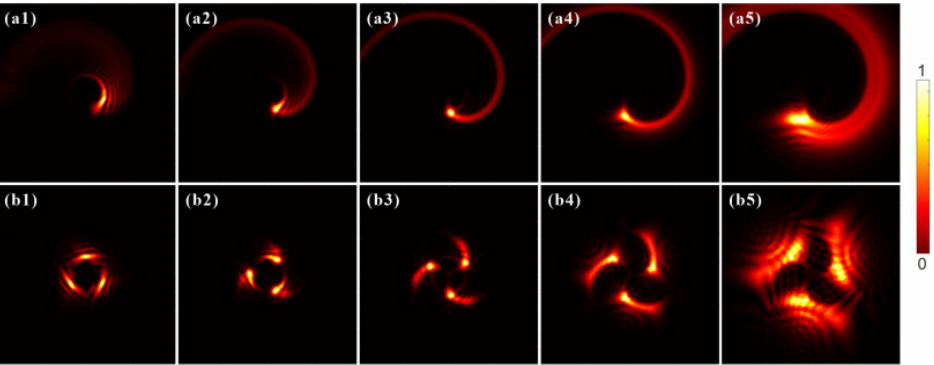
Figure 3. The focusing was carried out with a high-NA oil-immersion objective lens and the refractive index of the oil was n = 1.518. As the beam propagates in such a high-NA system, its intensity profile changes with respect to the propagation distance rapidly. It is observed in Figure 4a1 that, when MHCB with parameter K = 0, m = 3, α = 6 is at a distance of z = − 2 λ away from the focal plane, there exists a curved moon-shaped main lobe of light intensity rotating along the center of the optical axis, and some weaker side lobe light intensity distribution is in the periphery. As the beam approaches the focal plane—see Figure 4a1,a2—the strongest light intensity in the main lobe of light intensity rotates around the optical axis. At the same time, the peripheral side lobes contract together. The intensity distribution at the focal plane is very clearly observed as a spiral shape as shown in Figure 4a3. As the light passes through the focal plane, the spiral light intensity gradually spreads out to form a wider band-like light intensity distribution, and, at the same time, the center of the strongest light intensity rotates around the optical axis in Figure 4a4,a5. For the MHCB with m = 3, α = 6, three main lobes with some side lobes can be observed in the intensity profile in Figure 4b1,b2 when z = − 2 λ . As it approaches the focal plane, three spiral shape intensity distributions are clearly seen; see Figure 4b3. The location of the maximum intensity in the three main lobes continuously twists around the central propagation optical axis, which is similar to the MHCB with m = 1, α = 6. As it propagates to the position at z = 2 λ , the side lobes near the main lobe appear again and there are some interference strips between the three main lobes. It is also the difference between MHCBs with m = 3, α = 6 and m = 1, α = 6. Furthermore, it can be concluded that the number of main lobes is dependent on the number of multiramp mixed screw-edge dislocations m .